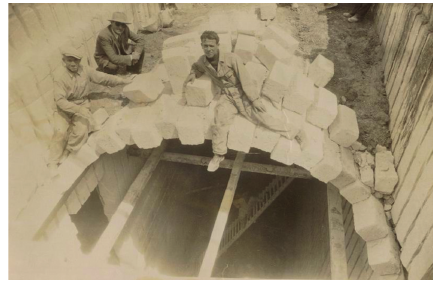
Figure 4: Historical image of vault construction.